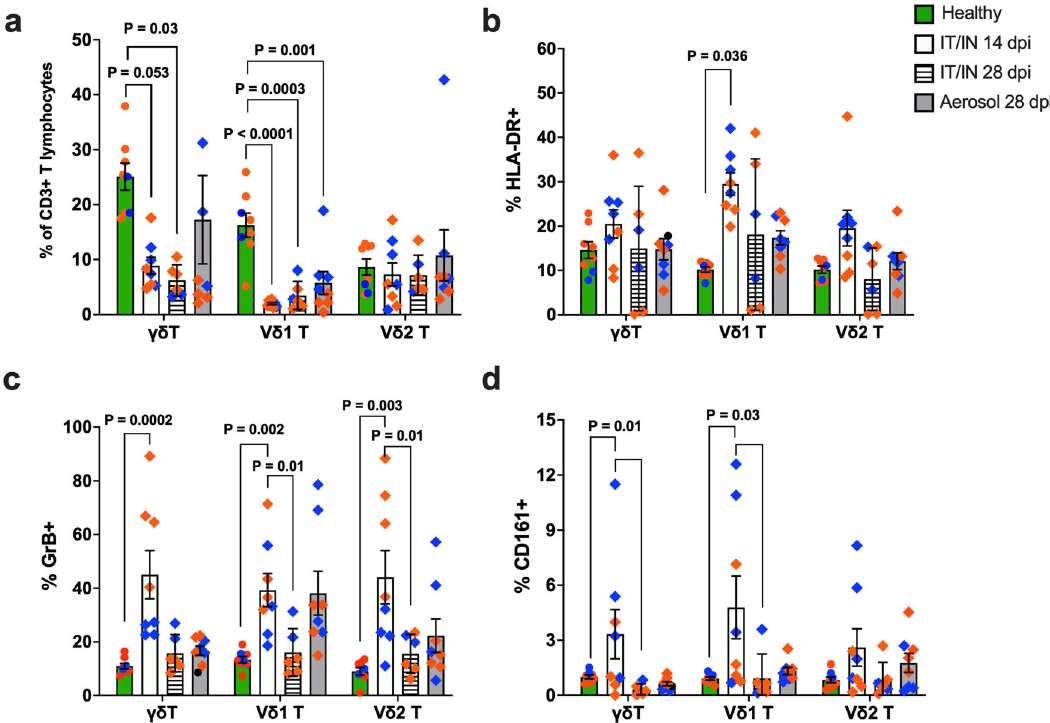
Fig. 7 Frequency, activation and functional phenotype of γδ T cells in BAL fl uid during SARS-CoV-2 infection. a Cross-sectional comparison of frequencies of total γδ T cells, V δ 1, and V δ 2 T cells in BAL fl uid from healthy nonhuman primates ( n = 8/group) including 6 RMs (orange circles) and 2 AGMs (blue circles) with the study cohort of SARS-CoV-2 infected nonhuman primates ( n = 8/group) comprising 4 RMs (orange diamonds) and 4 AGMs (blue diamonds) at 14 dpi and 28 dpi via IT/IN, or 28 dpi via aerosol challenge. Expression levels of HLA-DR ( b ), GrB ( c ), and CD161 ( d ) on total γδ T cells, V δ 1 T cells, and V δ 2 T cells in BAL ( n = 8/group). Graphs show mean and SEM. Healthy and infected animals were compared using Mann Whitney test and longitudinal comparisons between 14 dpi and 28 dpi were done using Wilcoxon matched-pairs signed rank